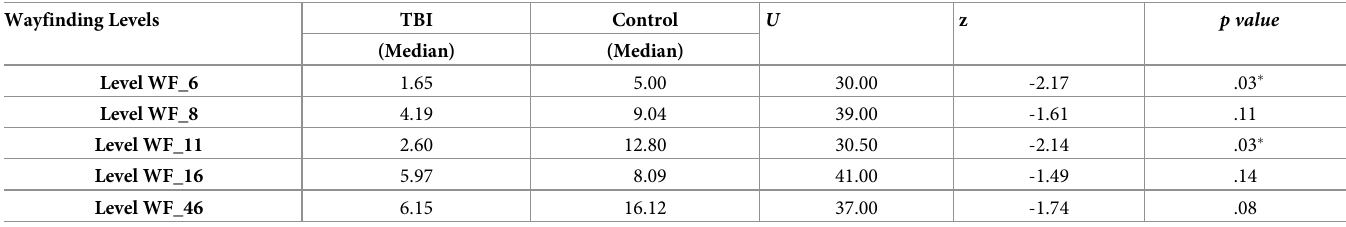
Table 3. Results of Mann–Whitney U test on map view duration on all wayfinding tasks between TBI and control group. Wayfinding Levels TBI Control U z p value